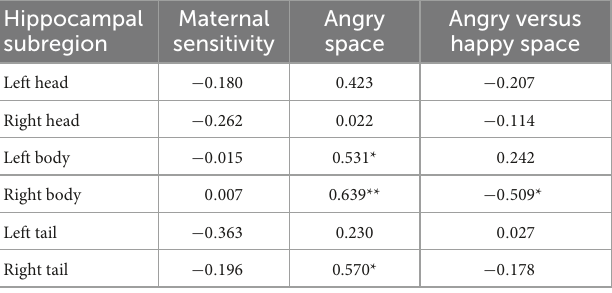
TABLE 3 Spearman Rho correlations between hippocampal subregion volume, maternal sensitivity, and relational memory in the space condition (i.e., Happy versus Angry and